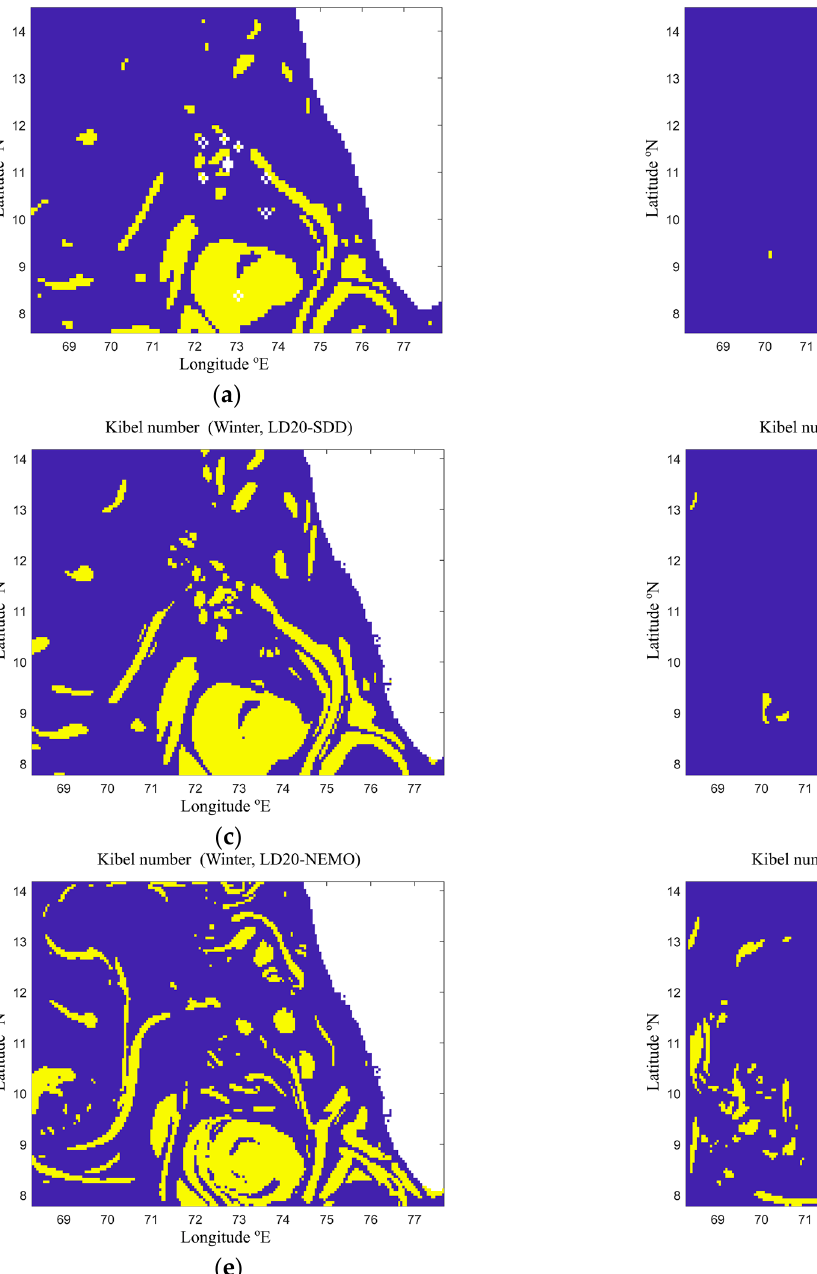
Figure 10. Maps of areas with high (Ki > 0.5, yellow) and low (Ki < 0.5, violet-blue) non-linearity in the Lakshadweep Sea in winter (left), and summer (right), for models CMEMS ( a , b ), LD20-SDD ( c , d ), LD20-NEMO ( e , f ).